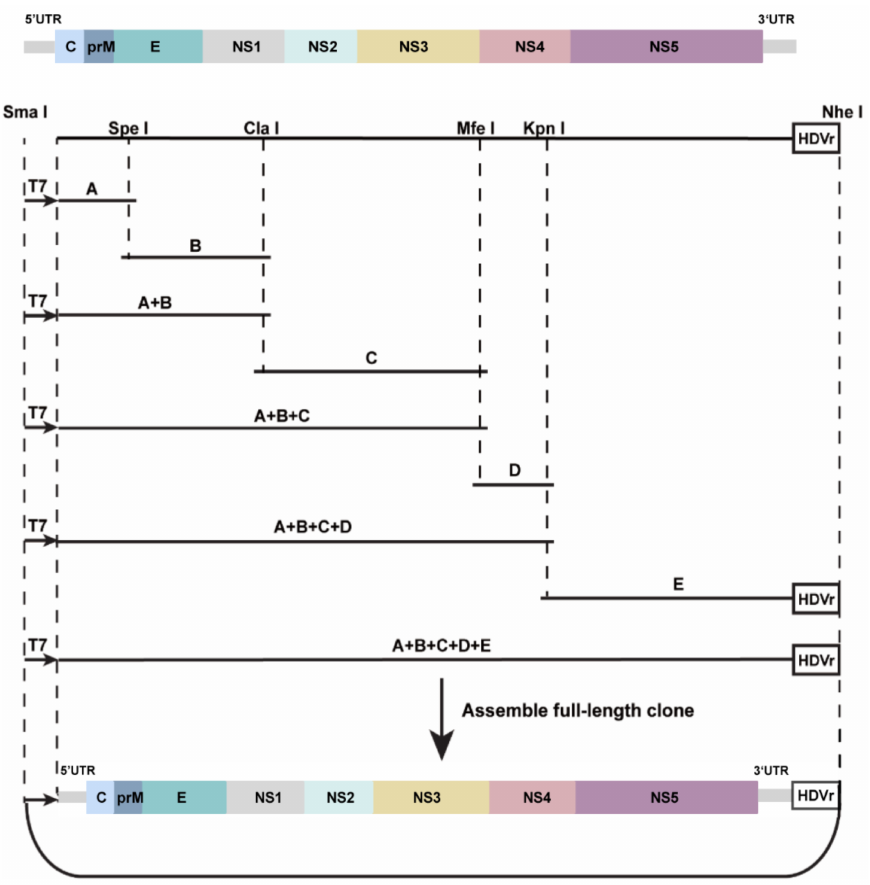
Figure 1. Schematic diagram of the cloning strategy to construct infectious clone for mosquito flavivirus strain YN15-283-02. Genome distribution and restriction sites used for genome assembly are shown. Five cDNA fragments (A–E) covering the complete MFV YN15-283-02 genome were amplified using RT-PCR. A T7 promoter was fused upstream of the 5 (cid:48) UTR in fragment A and an HDVr downstream of the 3 (cid:48) UTR in fragment